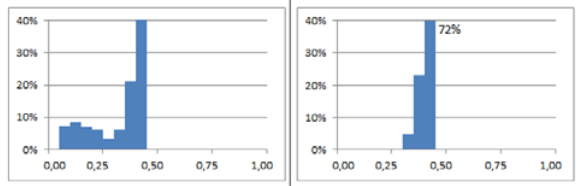
Figure 6. Histograms of the parameter “Thickness of saturated dump“, left: for the entire model area, right: for areas with known events The best fitted model was based on a combination of 15 input parameters: the elevation model and derived data, thickness and composition of the dump and groundwater characteristics. The result of this model is displayed in Figure 7. Observed events are outlined in black.